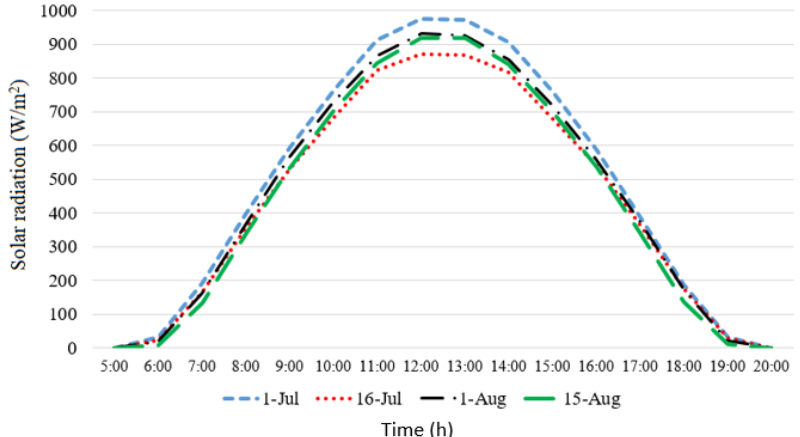
Figure 9. Hourly solar radiation in W/m 2 of different days of the site under study (during 2019).